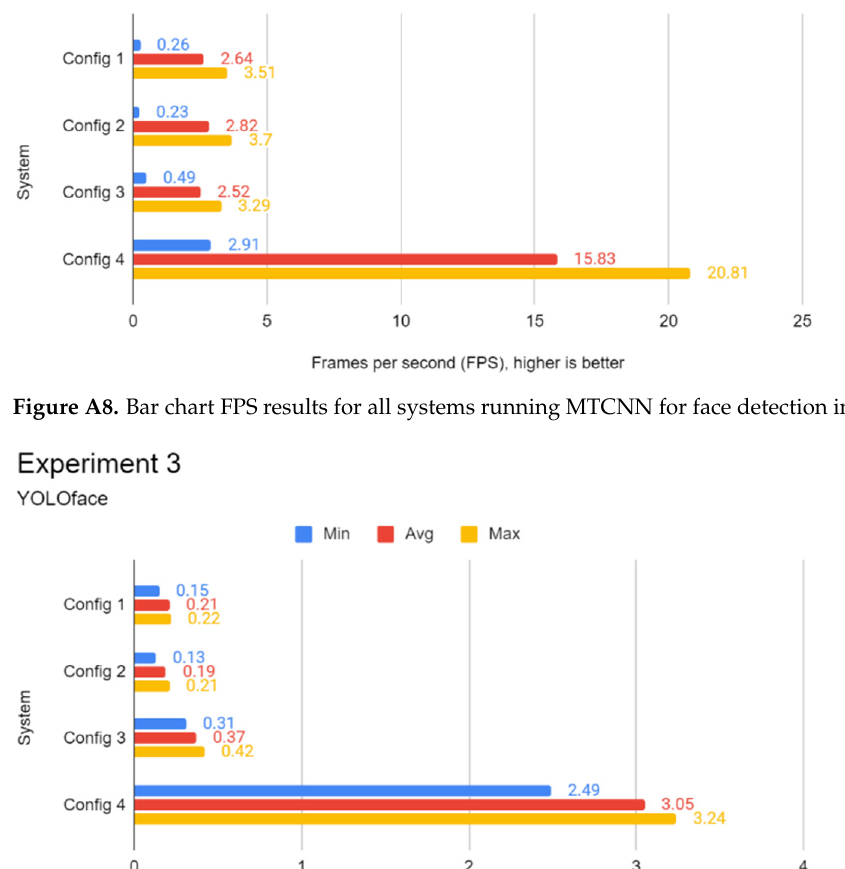
Figure A9. Bar chart FPS results for all systems running YOLOface for face detection in Experiment 3.